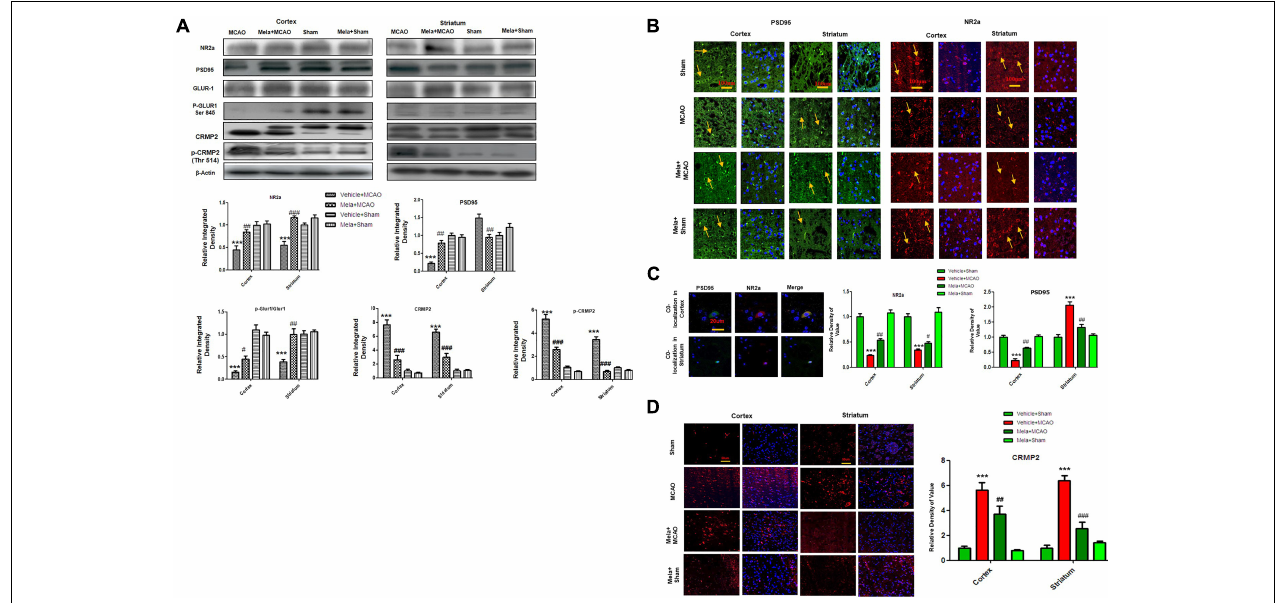
FIGURE 2 | Effect of melatonin on glutamate (Glu) receptor subunits. (A) Western blot analysis of NR2a, PSD95, GluR1, p-GluR1 (Serine 845), CRMP2, p-CRMP2 (Thr 514) from sham-operated control group, vehicle-treated MCAO, melatonin-treated MCAO animals and melatonin treated sham group ( n = 7 rats per group). The bands were quantified using ImageJ, analyzed by graph-pad prism-5 software. β -actin was used as control. Densitometric analysis was expressed in arbitrary units as the mean ± SEM for the indicated proteins. (B) Immunofluorescence reactivity of PSD95 and NR2a; ( n = 7 rats/group). The above data is representation of 3 numbers of experiments. Scale bar = 100 µ m and magnification 40 × . PSD95 and NR2a show cytoplasmic localization and was visualized by FITC and TRITC. (C) Double immunofluorescence of NR2a and PSD95 in ischemic brain. PSD95 was visualized by FITC and NR2a by TRITC. Scale bar = 20 µ m and magnification 40 × . (D) Immunofluorescence reactivity of CRMP2; ( n = 7 rats/group). The above data is representation of 3 numbers of experiments. Scale bar = 50 µ m. CRMP2 was visualized by Alexa-Flour 594. Symbols # represent significant difference values p < 0.05, while symbol ## represent p < 0.01 values for significant differences, symbol ∗∗∗ and ### shows p < 0.001. Symbols ∗ shows significant difference relative to sham control while # shows significant difference relative to